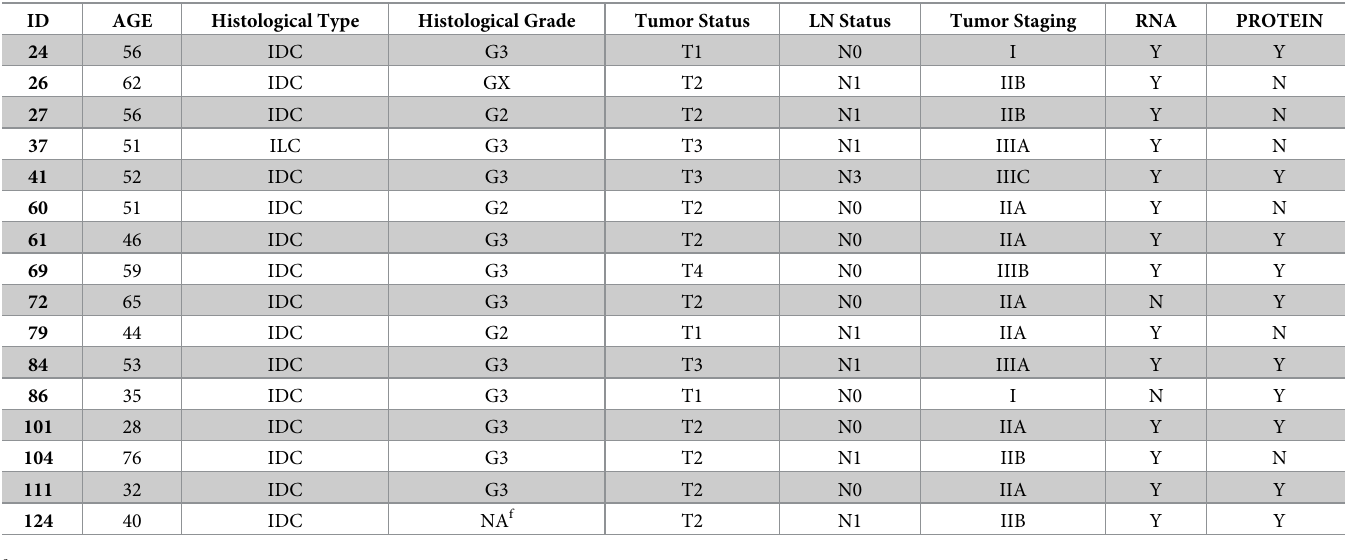
Table 2. Trastuzumab-treated HER2+/ER- tumors e .